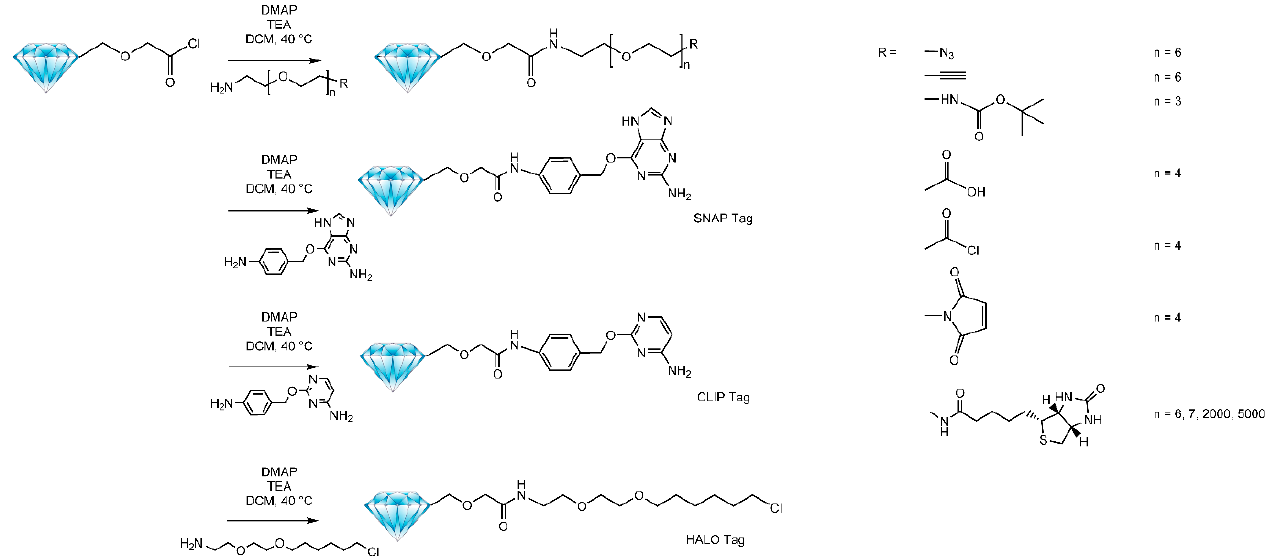
Figure 2. FTIR spectra of carboxylic acid enriched nanodiamonds (blue line). After coupling with amine–PEG–azide (red line), formation of the amide bond is observed via the amide I and amide II peaks at 1650 cm − 1 and 1570 cm − 1 , respectively, along with the azide stretching peak at ~2100 cm − 1 (pink shading).